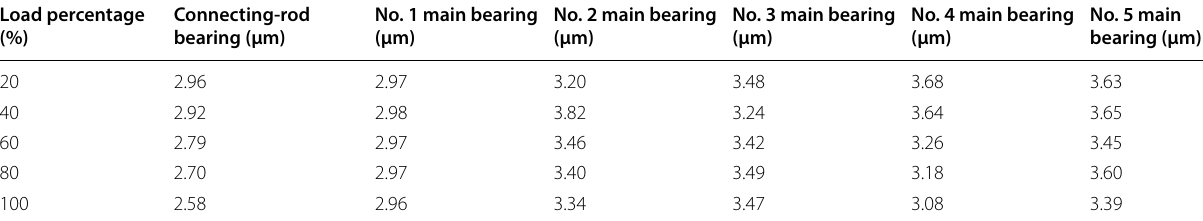
Table 8 Minimum film thicknesses of connecting‑rod bearing and main bearings at 2200 r/min and different load percentage Load percentage (%)